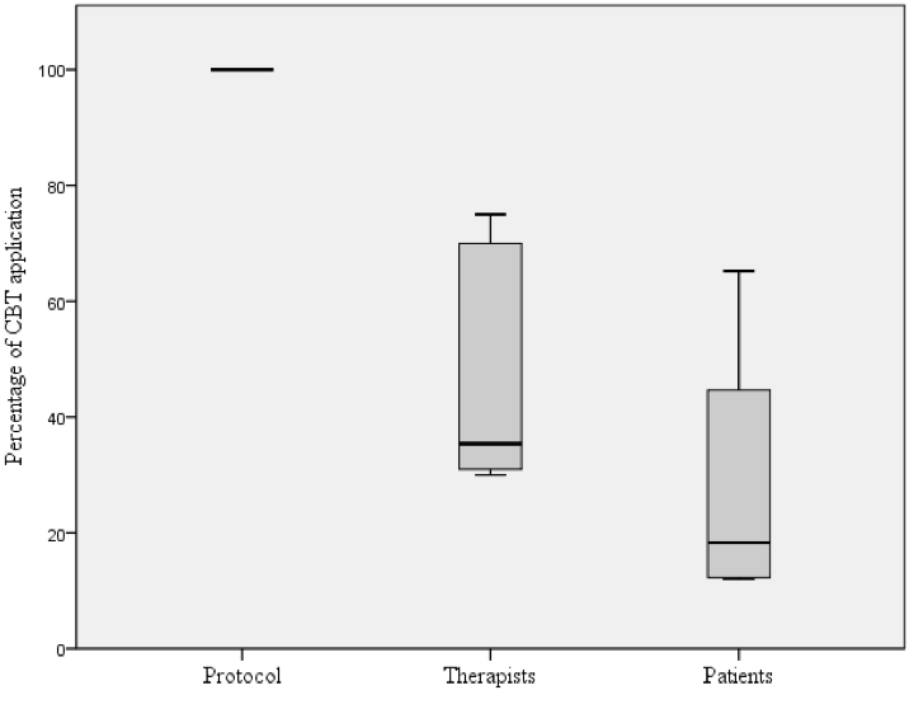
Figure 1. Range and median percentage of cognitive behavioral therapy application by therapists and